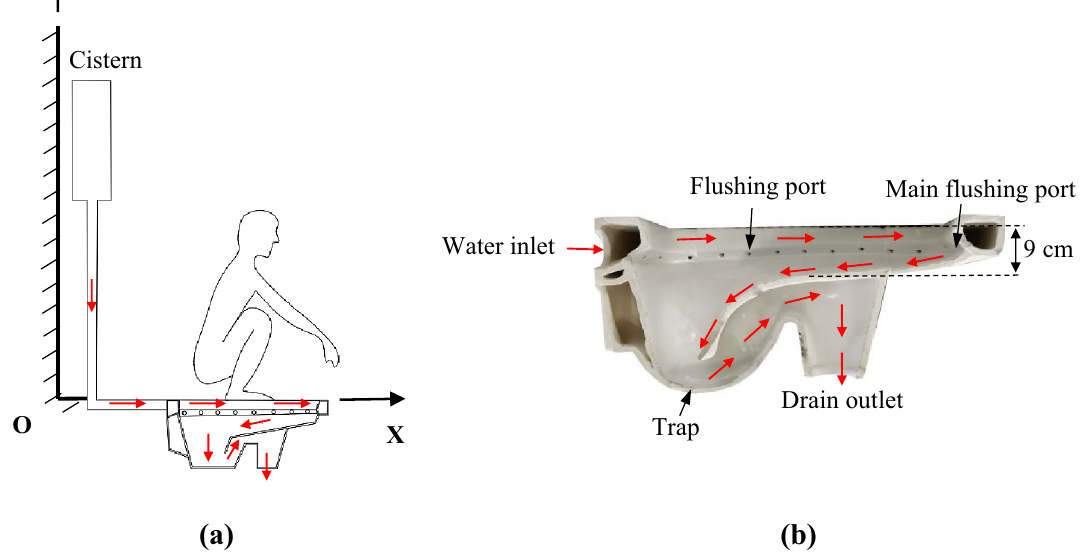
Figure 1. Schematics of a squat toilet system and water flow paths: ( a ) a user on the toilet, ( b ) sectional view of a realistic squat toilet and the path of flushing water